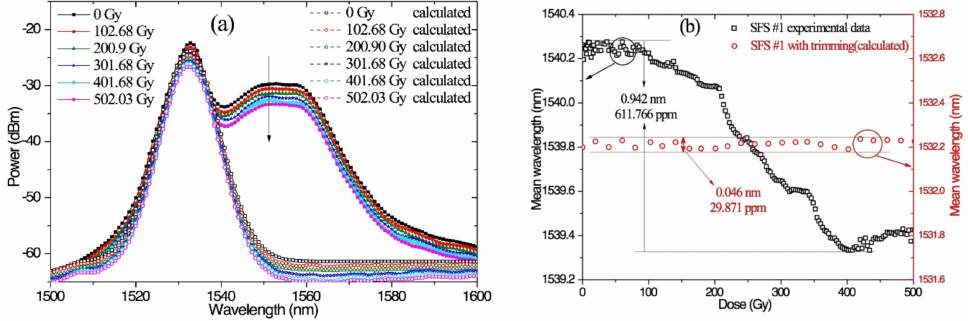
Figure 6. ( a ) Experiment results of the spectral evolution of SFS#1 and calculated Gaussian-like spectral evolution with irradiation dose and ( b ) mean wavelength drift of SFS#1 (experimental data) and calculated mean wavelength drift of SFS with